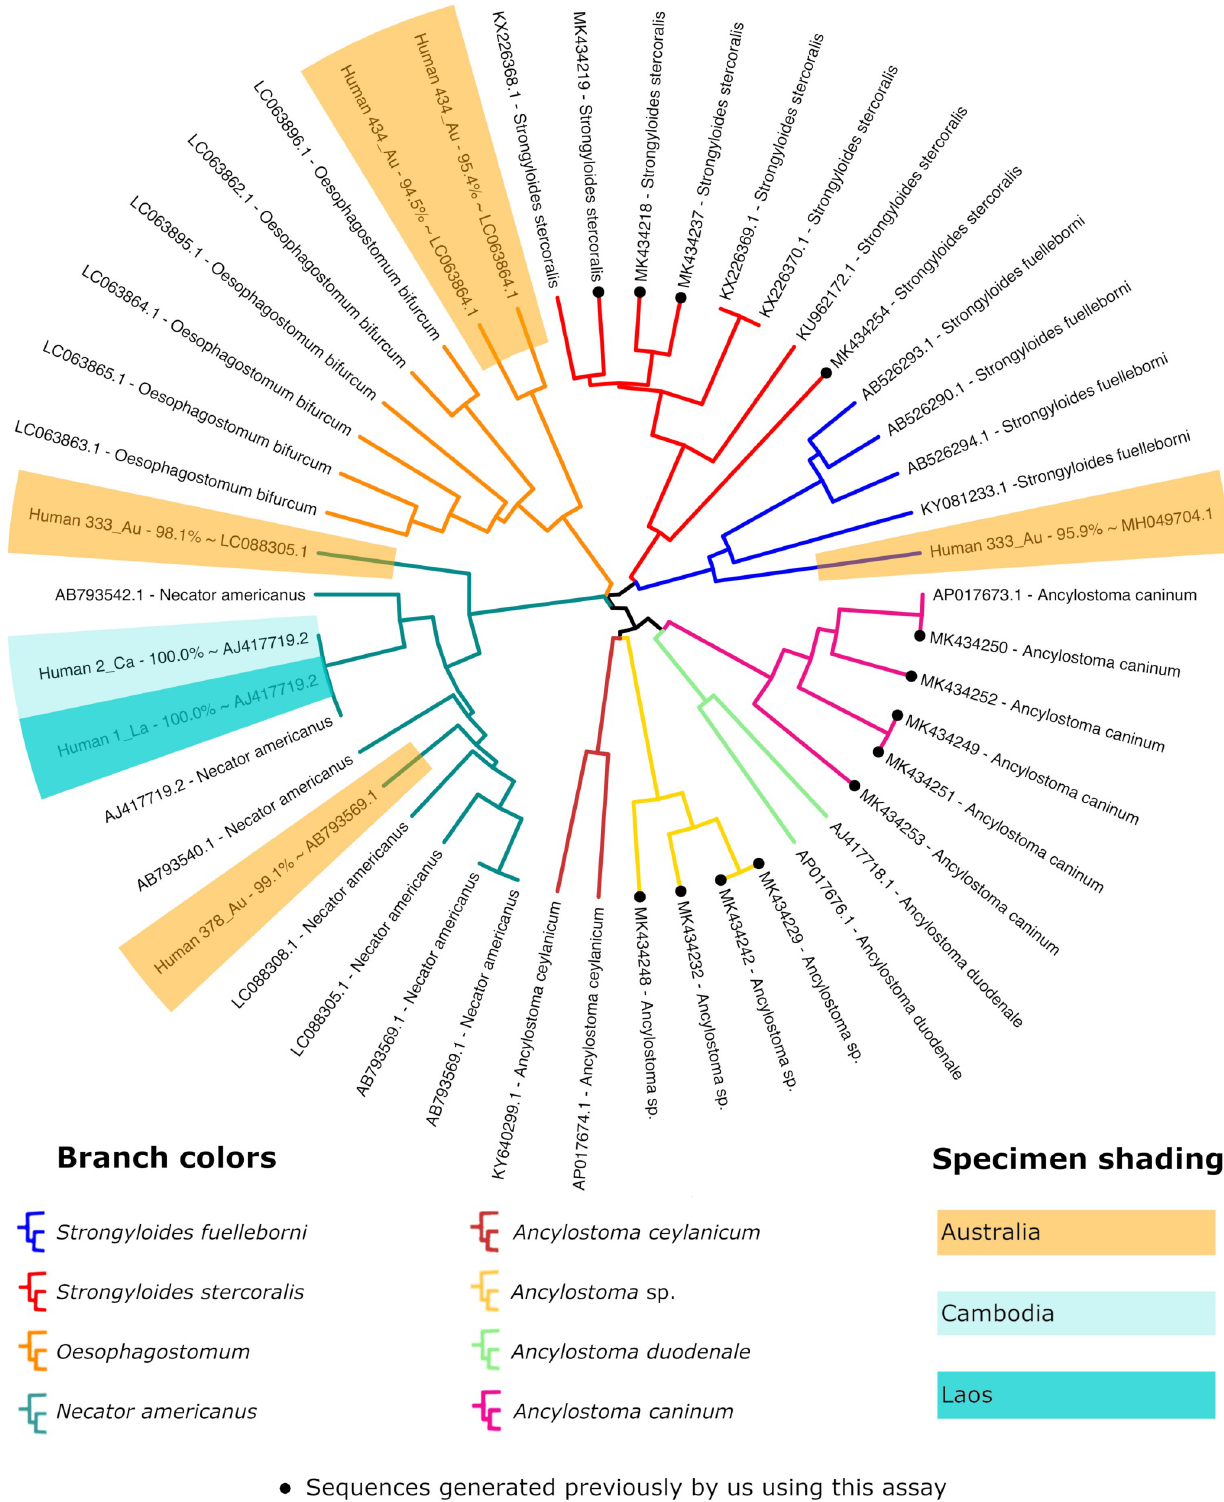
Fig 4. Dendrogram of cox1 sequences from Strongyloides spp. and hookworms. This figure demonstrates that the cox 1assay described here is broadly specific for Strongyloides spp. and some strongylids. Fragments of cox1 from Ancylostoma spp., Oesophogostomum and Necator americanus have been amplified and sequenced using this assay. Additionally, we previously detected cox1 sequences from Metastrongylus sp., a rotifer, and some unknown nematodes using this approach [21].The sequences generated in this study are shaded in colors according to their country of origin and those generated by us in a previous study are marked with a black dot on the associated branch tip. The sequences used to construct this dendrogram are included in S3 File.